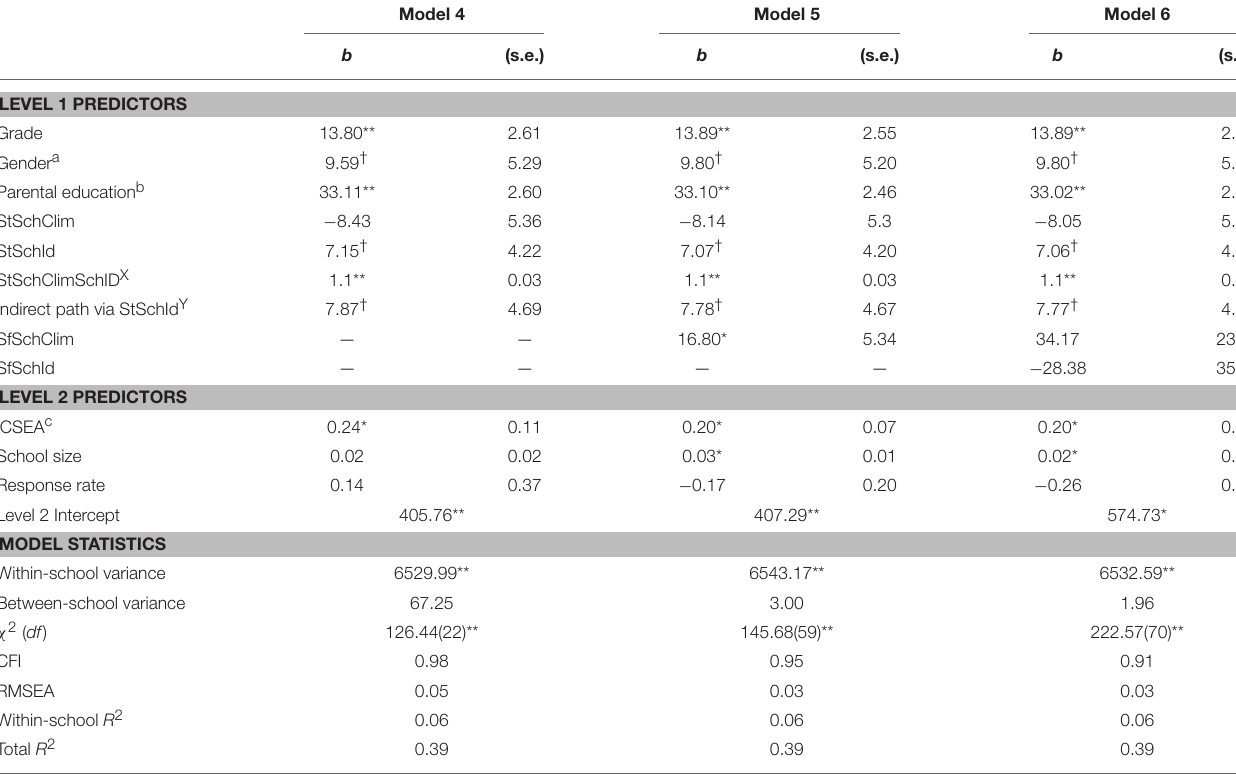
TABLE 6 | Multilevel SEM results for models 4–6 explaining NAPLAN